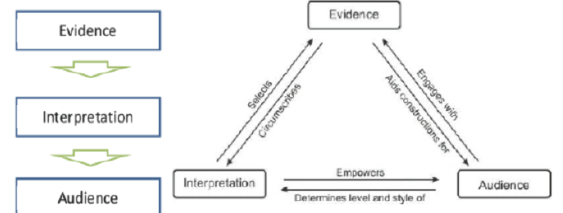
Figure 3. Copeland’s Information Flow of Approaches